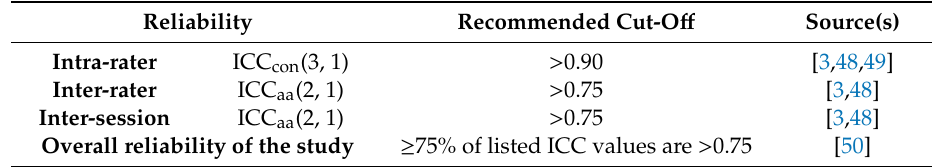
Table 8. Recommended cut-o ff values for ICC